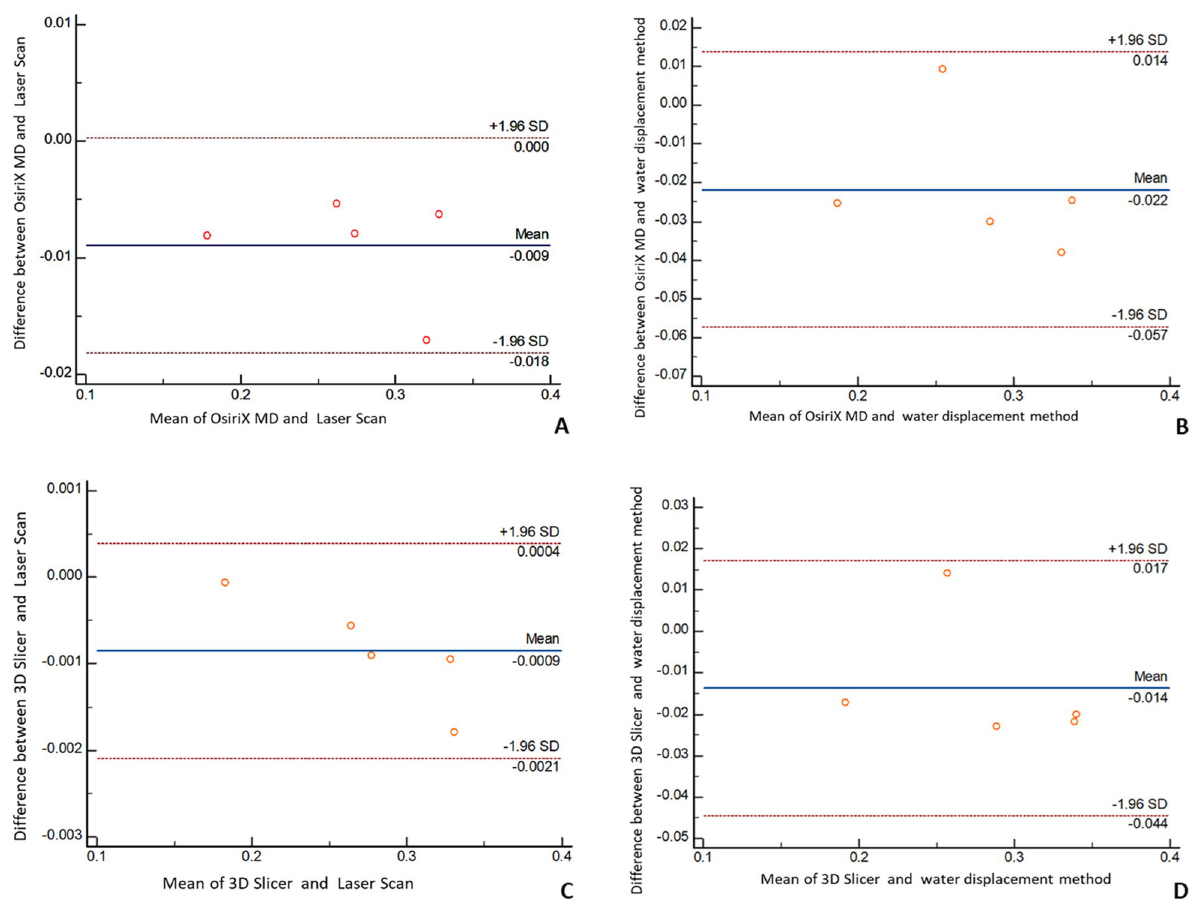
Figure 6. Invitro validation. Bland–Altman Plot comparison between (A) CBCT segmented volumes from OsiriX MD and real volumes from Laser scans. (B) CBCT segmented volumes from OsiriX MD and real volumes from water displacement method (C) CBCT segmented volumes from 3D Slicer and real volumes from Laser scans. (D) CBCT segmented volumes from 3D Slicer and real volumes from water displacement method. The difference between the measurements is plotted against their mean.